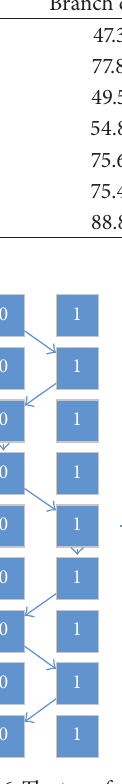
Figure 6: The transformation relationship between ant colony paths and test